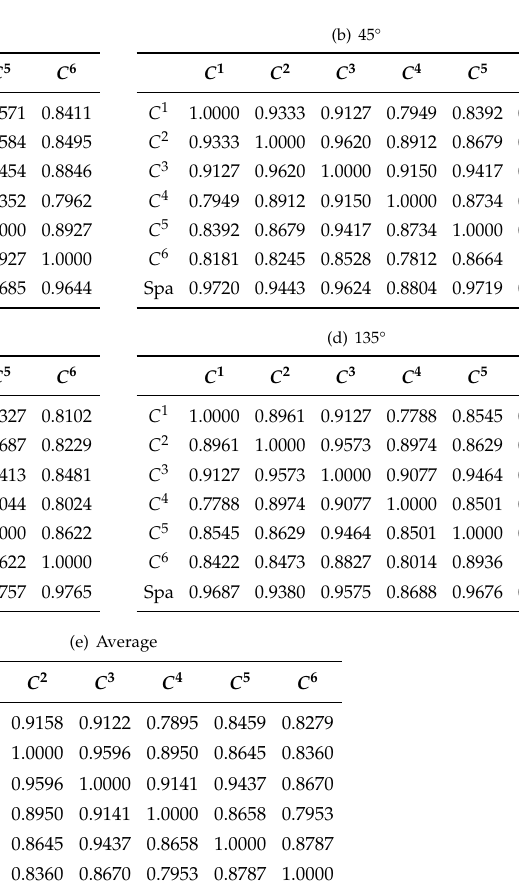
Table 1. Inter-channel correlation between the six spectral channels relatively to the polarization angle of analysis. Last line of each subtable is the spatial correlation within each channel. Values are averaged over the ten multispectral images from [31]. Last subtable (e) is the average over the four polarization